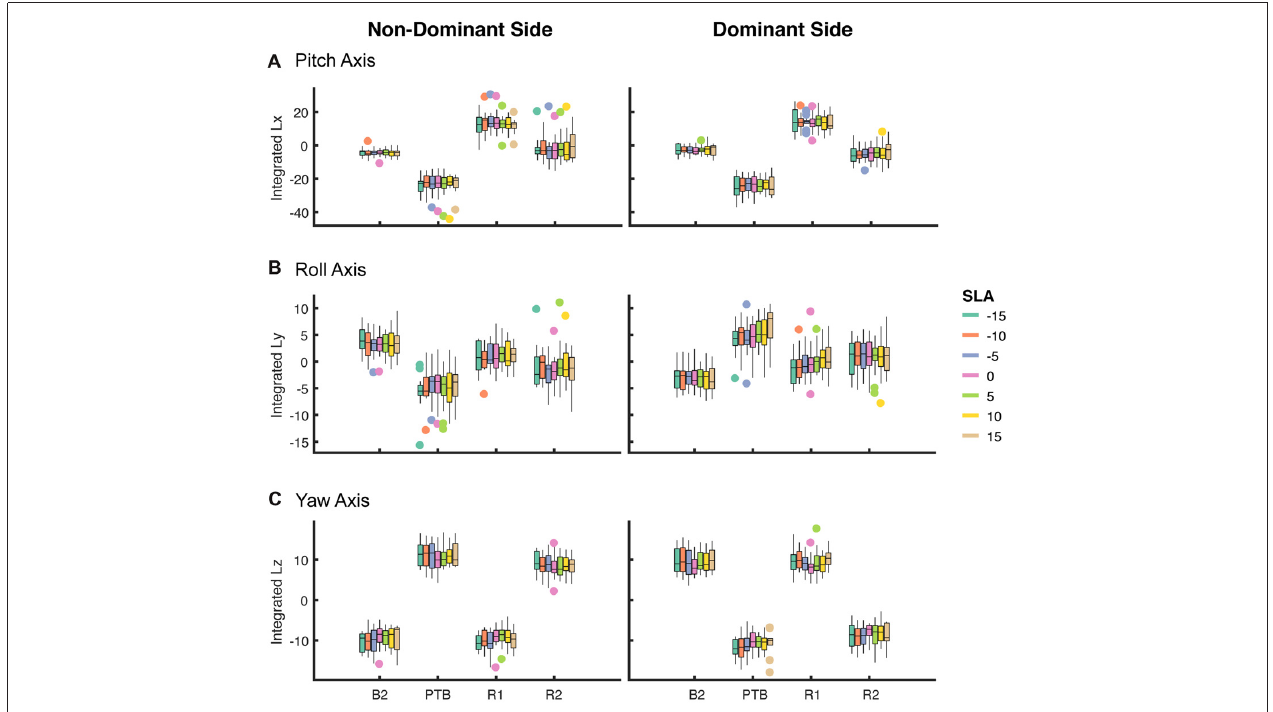
FIGURE 6 | Box plot of integrated angular momentum about the (A) pitch, (B) roll and (C) yaw axes at baseline step (B2), perturbation step (PTB) and recovery steps (R1 and R2) across each level of achieved asymmetry ( N = 19) for perturbations on the non-dominant (left column) and dominant (right column) sides.